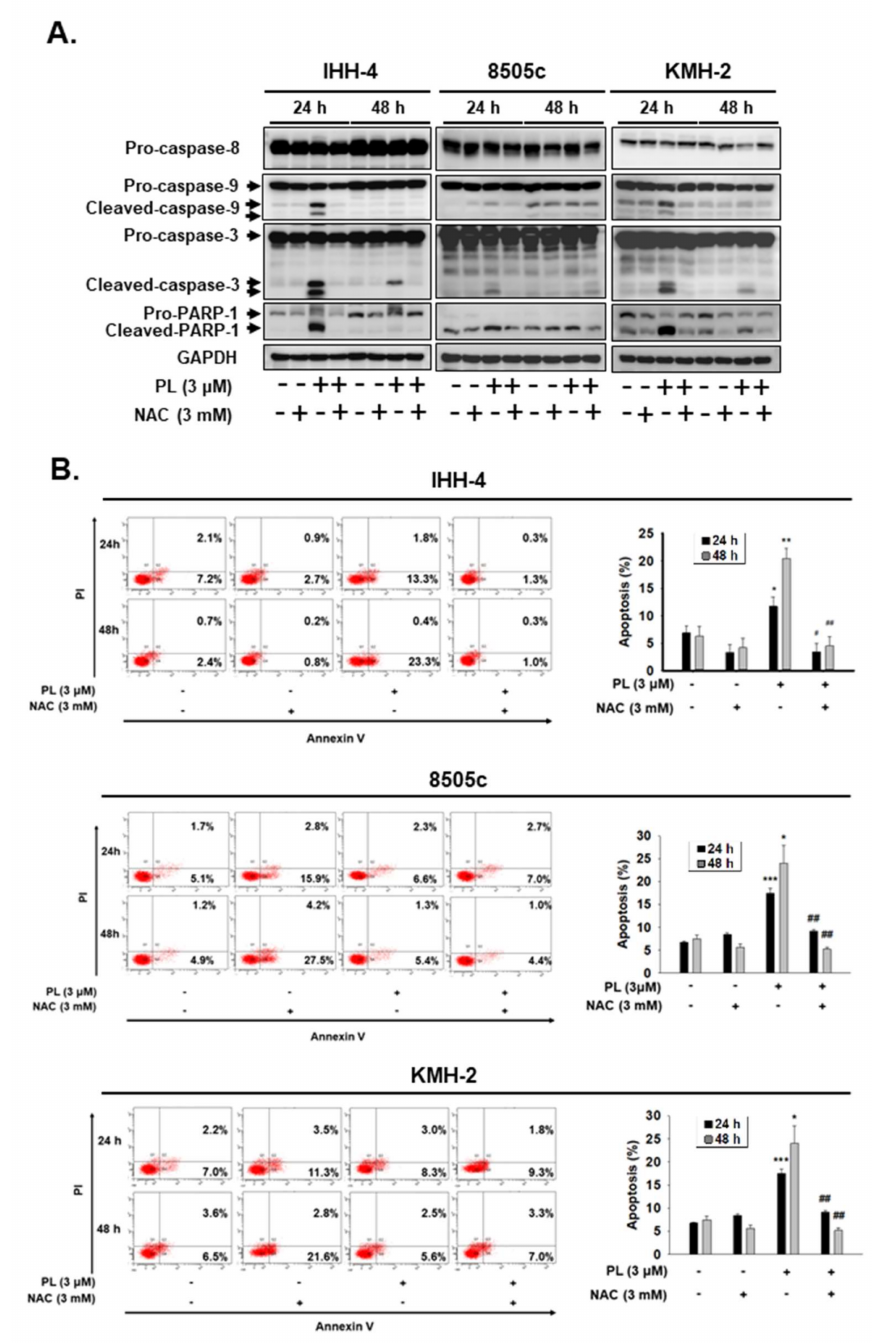
Figure 5. Piperlongumine (PL)-mediated cellular apoptosis was regulated by inducing reactive oxygen species (ROS) in human thyroid cancer cells. Three human thyroid cancer cells were treated with